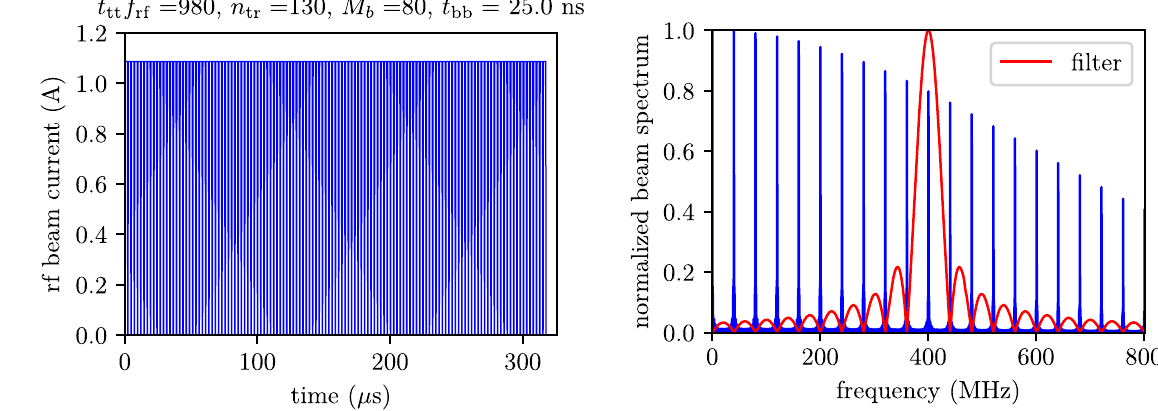
FIG. 3. Left: an example of the amplitude of the rf component of the beam current within one turn for FCC-hh filling scheme with a single abort gap. Right: corresponding amplitude of the beam spectrum (blue) and the amplitude of the filter function